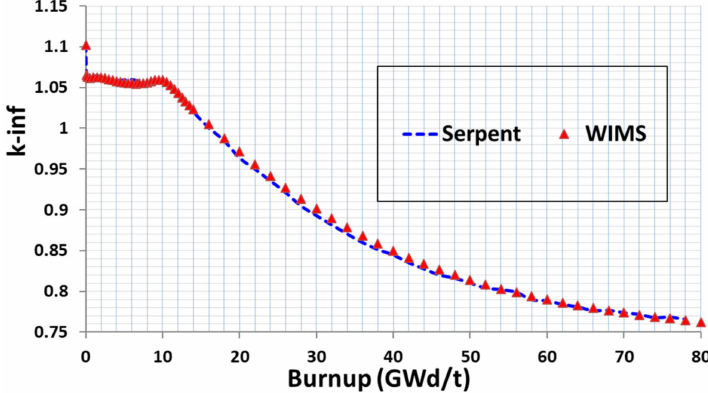
Figure 11. Serpent vs. WIMS results benchmark for the EPR 2D assembly (2.1 wt% + 8 Gd), depletion analysis up to 80 GWd / t. Table 2. Serpent vs. WIMS results benchmark for EPR 2D assemblies (BOL 0.5 GWd / t, nominal power,